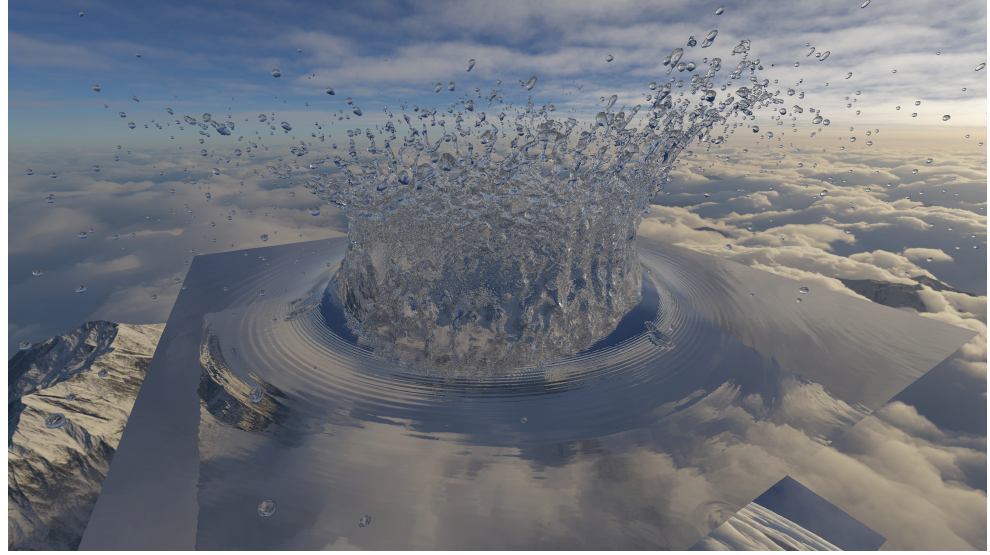
Figure 8. Esoteric Pull in-place streaming with FP16C memory compression [13] enables a colossal 940 × 940 × 800 lattice resolution on a single 48GB GPU, such as demonstrated here with a raindrop impact simulation. This figure is included in the Supplementary Files as a